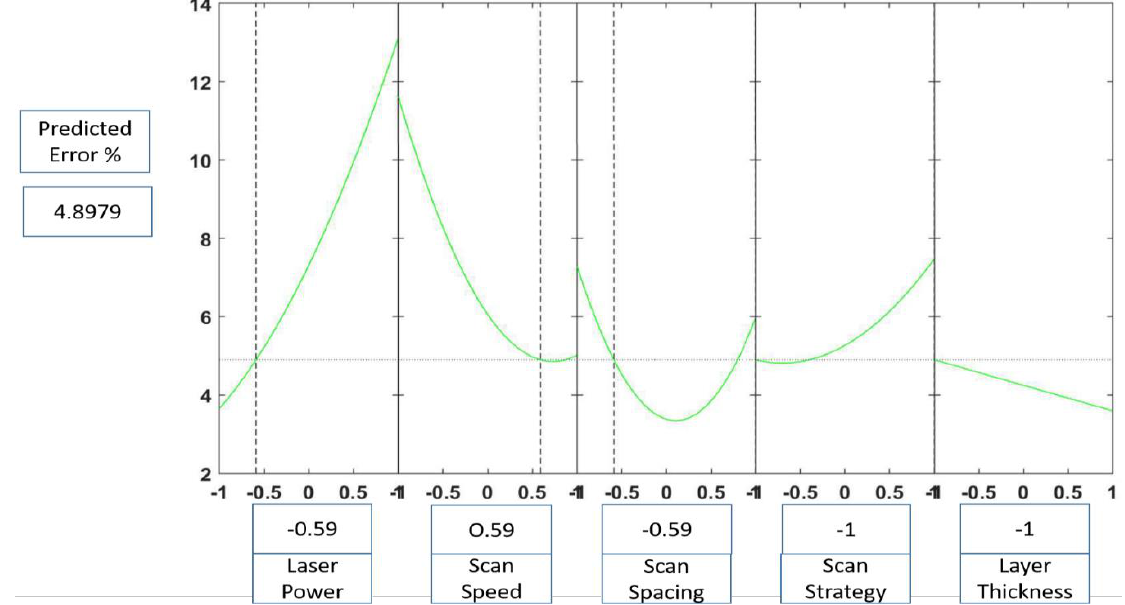
Figure 6. Prediction slice plots created using the developed regression equation.